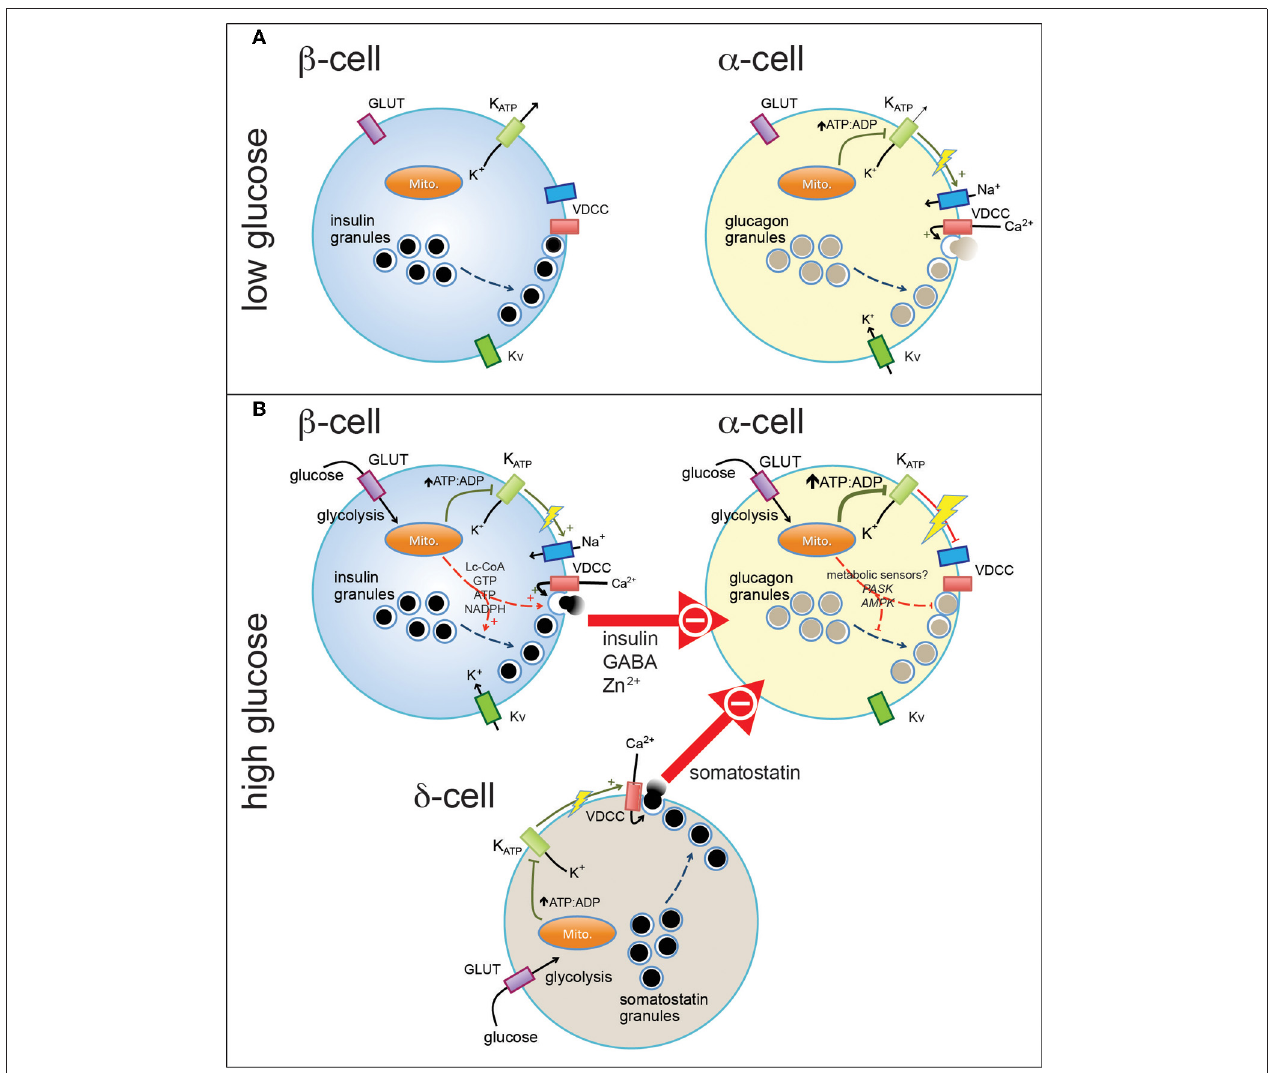
FIGURE 1 | Pancreatic endocrine cells are regulated by intrinsic and paracrine signals in response to glucose. At basal glucose levels pancreatic β -cells ( A , left ) are electrically inactive, owing to their open ATP-sensitive K + (K ATP ) channels and resultant hyperpolarized membrane potential, and thus do not secrete insulin. In contrast, α -cells in the presence of low glucose ( A , right ) are electrically active, due to a relatively elevated ATP/ADP ratio (even at low glucose). This results in closure of most, but perhaps not all, K ATP channels and a depolarized membrane potential that allows action potential firing mediated by a combination of voltage-dependent Na + , Ca 2 + (VDCC), and K + (Kv) channels. Entry of Ca 2 + through VDCCs triggers the exocytosis of glucagon-containing secretory granules. When plasma glucose is increased (B) , glucose enters pancreatic islet cells through